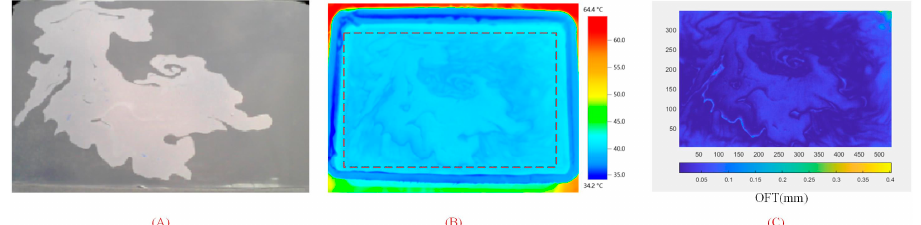
Figure 16. ( A ) RGB image of oil spill scene at 15:27 on 3 August 2022; ( B ) thermal infrared image of oil spill scene at 15:27 on 3 August 2022; ( C ) OFT distribution map at 15:27 on 3 August 2022.